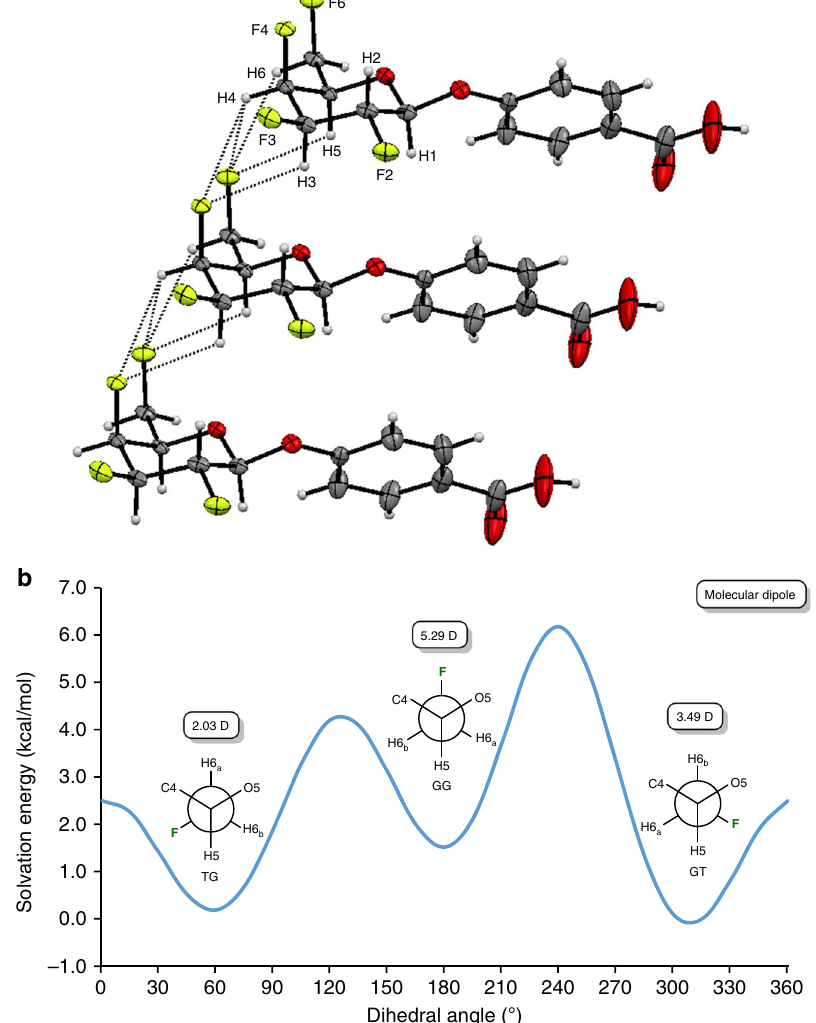
Fig. 3 Conformation of compound 27 . a Crystal molecular packing arrangement of galactoside analog 27 highlighting possible C − F···H − C interactions (dot line). ORTEP diagram showing 50% thermal ellipsoid probability, carbon (gray), oxygen (red), fl uorine (light green), hydrogen (white); b Relative energy of the dihedral angle plot (CAM-B3LYP-D3/6-31 + G(d,p)) for rotation about C5 − C6 bond for compound 27 , along with their calculated molecular dipole moment (shown in the